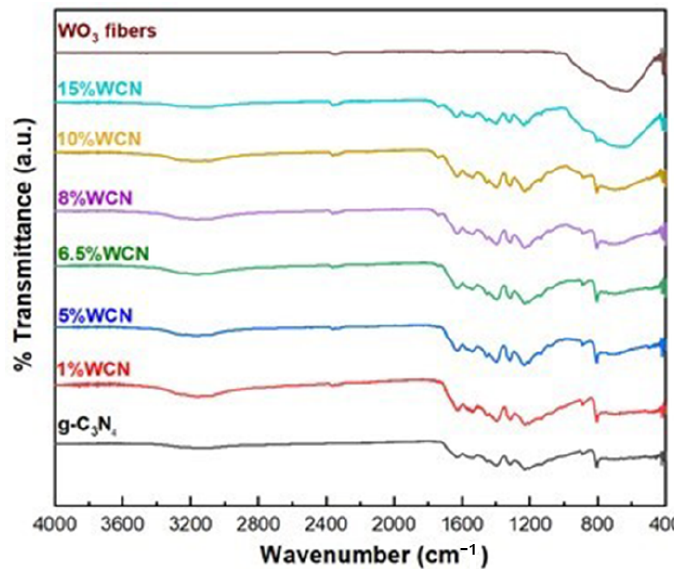
Figure 2. FT-IR spectra of WO 3 fibers, g-C 3 N 4 and composite materials of WO 3 /g-C 3 N 4 .